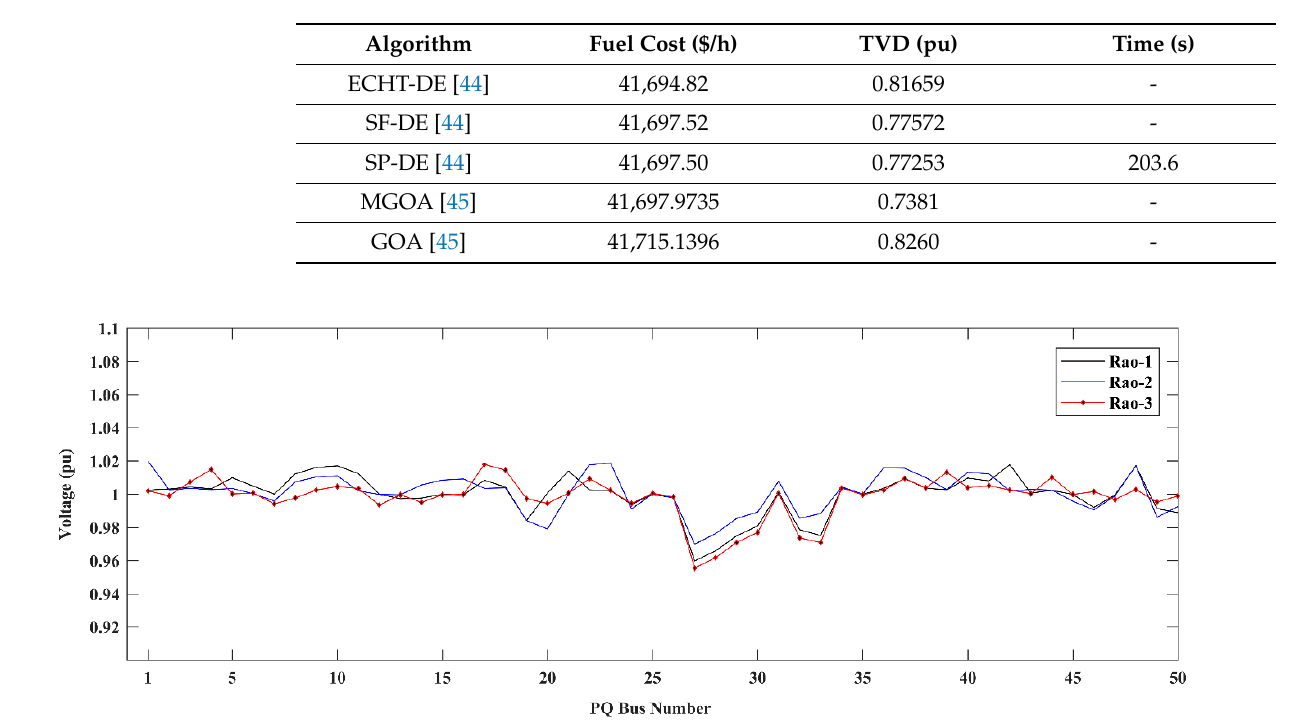
Figure 7. Voltage profile for the IEEE 57-bus system.